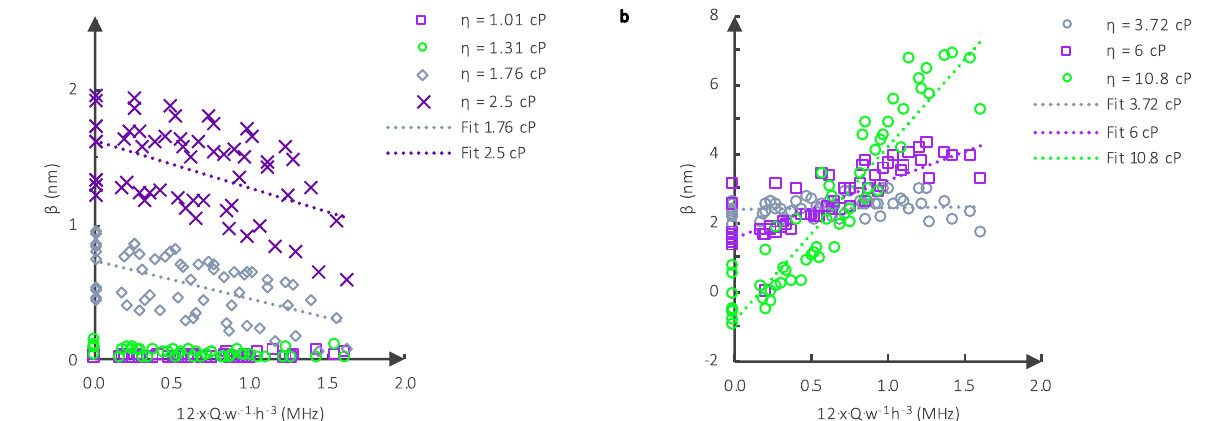
Fig. 4 Experimental determination of the slip length, β . a Case 1: Low viscosity, η < 3 mPa . s. Slip length for different solutions characterized by their viscosities as a function of the fl ow effort (12 . x . Q/(w . h 3 ). β decreases with the increase in the viscous pressure. b Case 2: Medium viscosity, 3 mPa . s < η ≤ 10.8 mPa . s. Slip length for different solutions as a function of the fl ow effort 12 . x . Q/(w . h 3 ). β increases and reaches a maximum. The slip length is plotted independent of d f and the data show that β does not depend on the contact